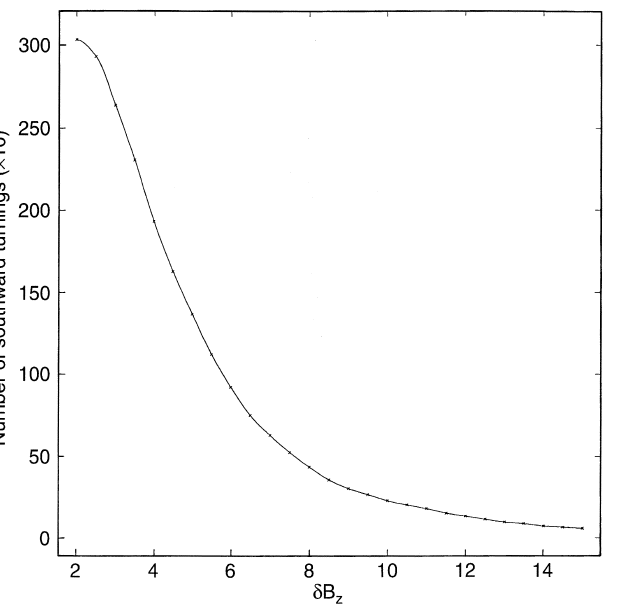
P the dynamic pressure. The largest (cid:100) B both B ( t ) and B ( t 1h) are large in magnitude. Bowe z z (cid:135)